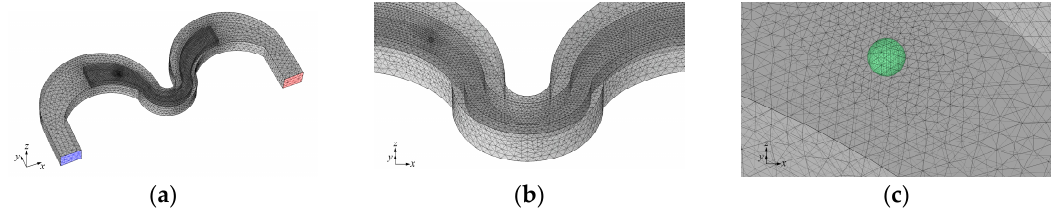
Figure 4. ( a ) Meshed simulation domain for the FSI simulation. The fluid enters the domain through one of the straight section ends (blue surface) and exits through the other side (red surface); ( b ) detail of the different sized meshes. The upper one corresponds to the region of the domain where the particle will translate through the curve; ( c ) zoomed section of the mesh showing the particle domain (green) at its initial position inside the